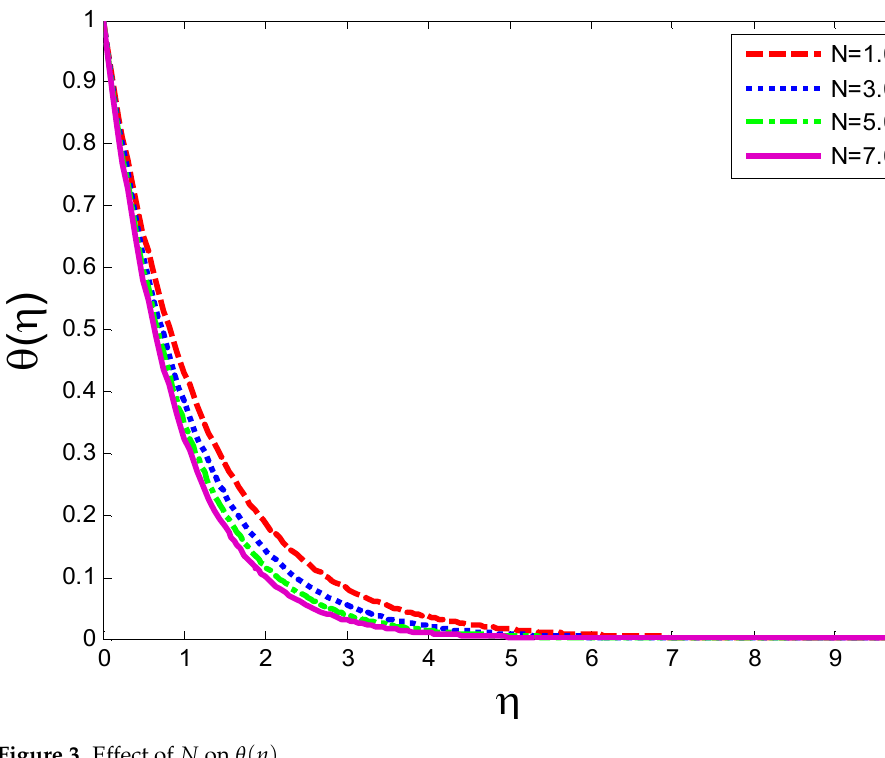
Figure 3. Effect of N on θ ( η ) .